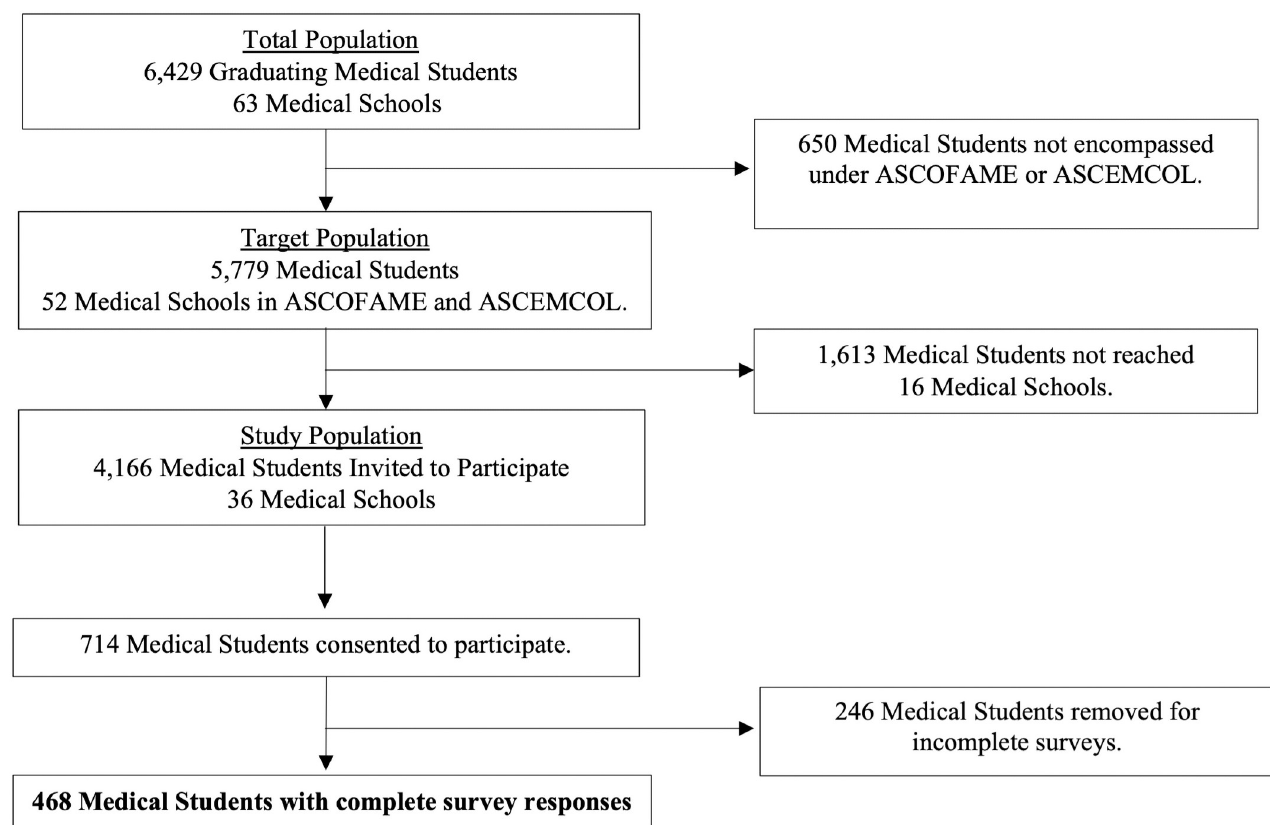
Fig 1. Study sample.